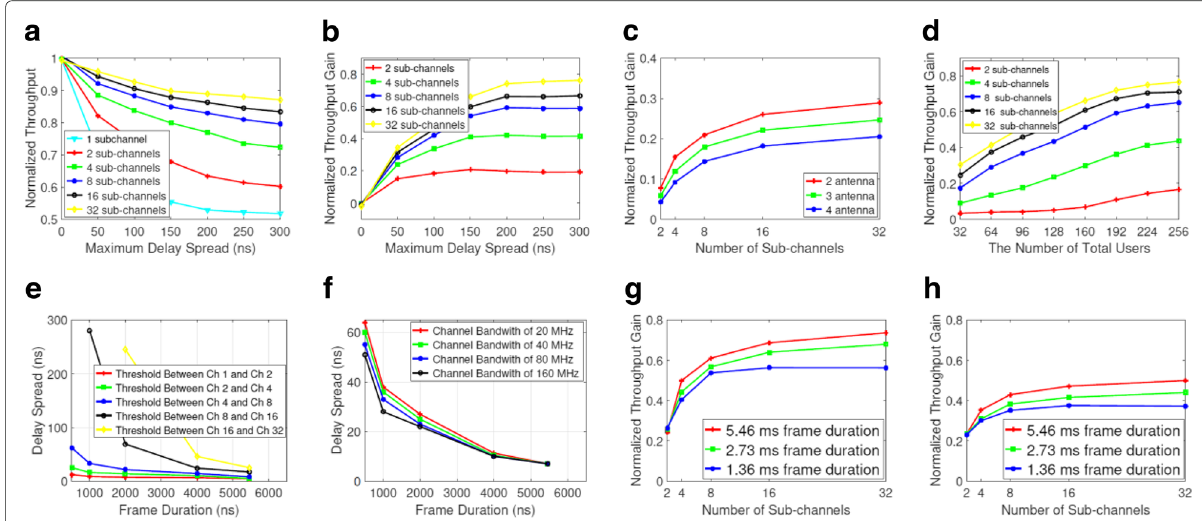
Fig. 11 Experimental results with either emulated or actual wireless channels on 2.4 GHz. a Normalized throughput for different number of sub-channels across channel delay spreads. b Normalized throughput gain for different number of sub-channels across channel delay spreads. c Normalized throughput gain versus antenna numbers on the AP for 2 selected users. d Throughput gain versus the number of total users in the coverage of the AP. e Sub-channel division threshold changes with frame duration. f Sub-channel division threshold changes with channel bandwidth. g Normalized throughput gain in emulated IEEE TGn channel model. h Normalized throughput gain in an actual office